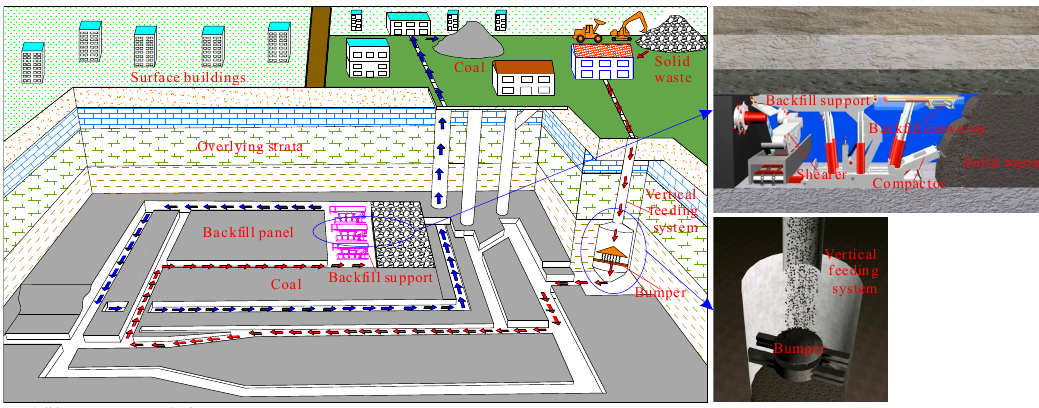
Figure 2. Principle of solid backfill mining.